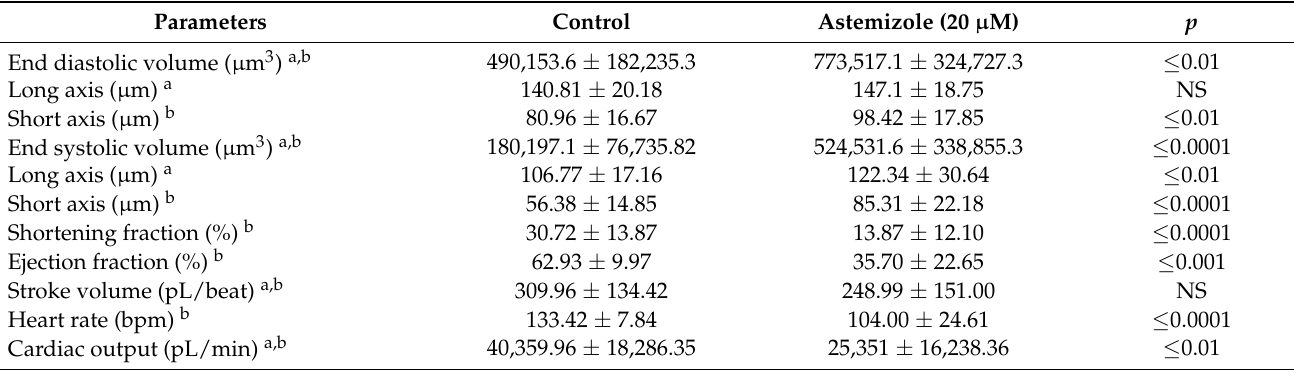
Table 2. Comparison of multiple cardiac performance endpoints between control and astemizole-treated zebrafish aged at 72 h